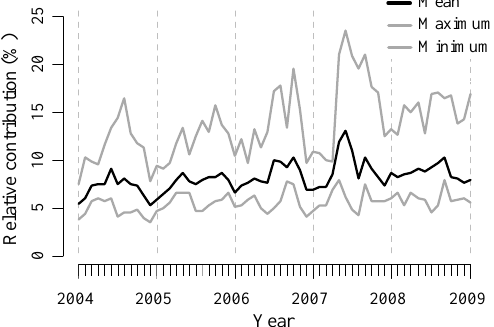
Fig. 6. Monthly mean, minimum and maximum relative contribu- tion of the WWTPs (Mol and Geel) to the river flow at the outlet station (Varendonk) of the Grote Nete catchment.